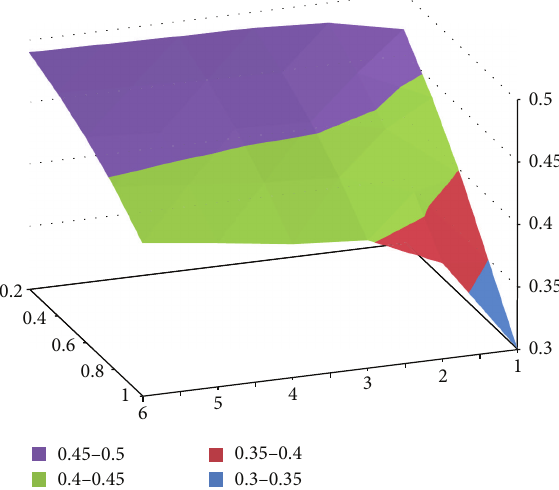
Figure 3: Solution of (9) for 𝐹 𝑄